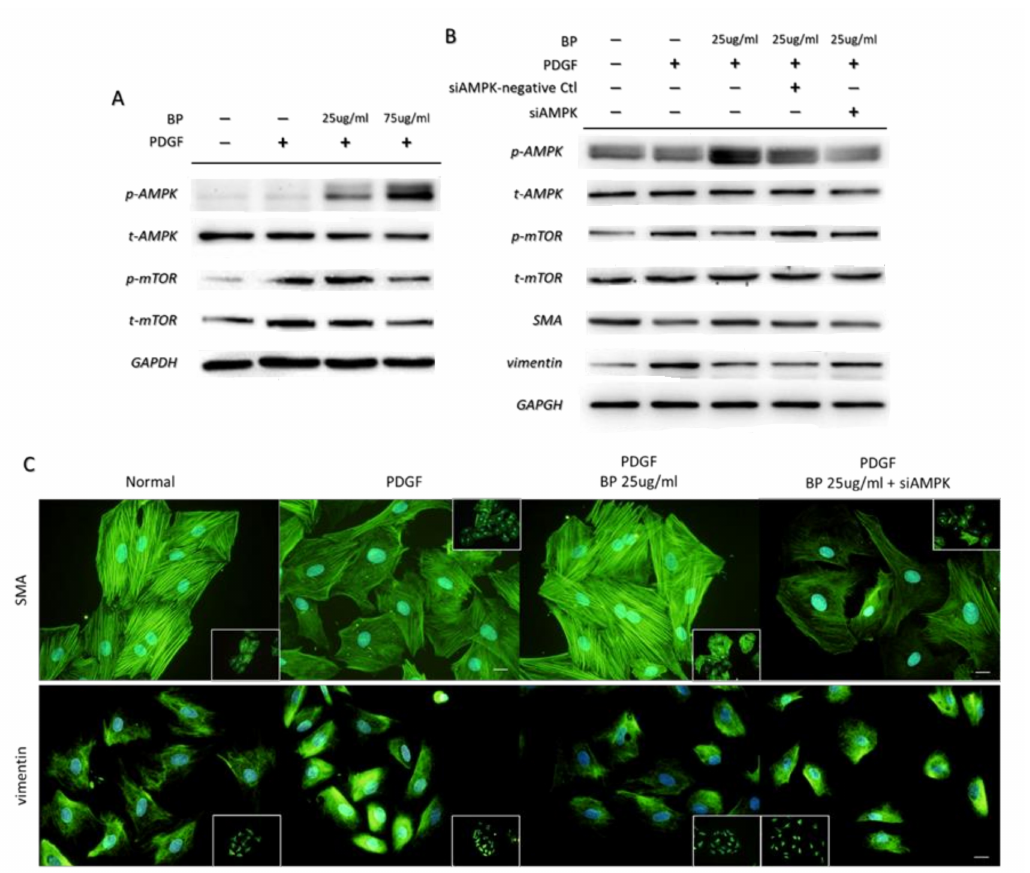
Figure5. BPinhibitedthePDGF-inducedphenotypic switchbyactivatingAMPK.( A )Proteinexpression of AMPK and mTOR after treatment of PDGF and BP for 24 h; ( B ) Protein expression of AMPK, mTOR and phenotypic markers in PDGF-induced A7r5 treated without or with BP in the absence or presence of siAMPK; ( C ) Representative images of PDGF-induced A7r5 treated without or with BP in the absence or presence of siAMPK. Scale bar = 50 µ